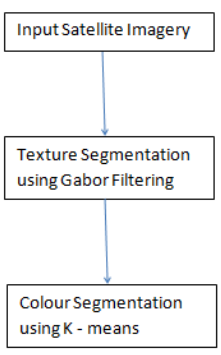
Figure 5: Work flow for Gabor